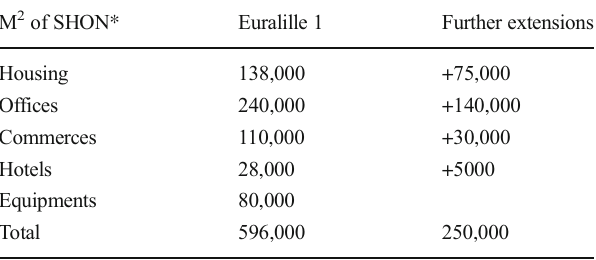
Surfaces constructed and functions in B Euralille CBD